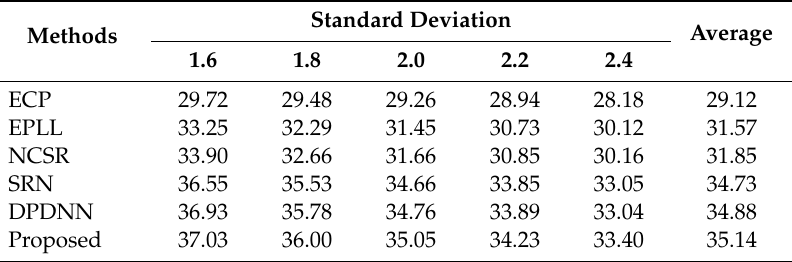
Table 1. The PSNR results of deblurred images for all evaluated